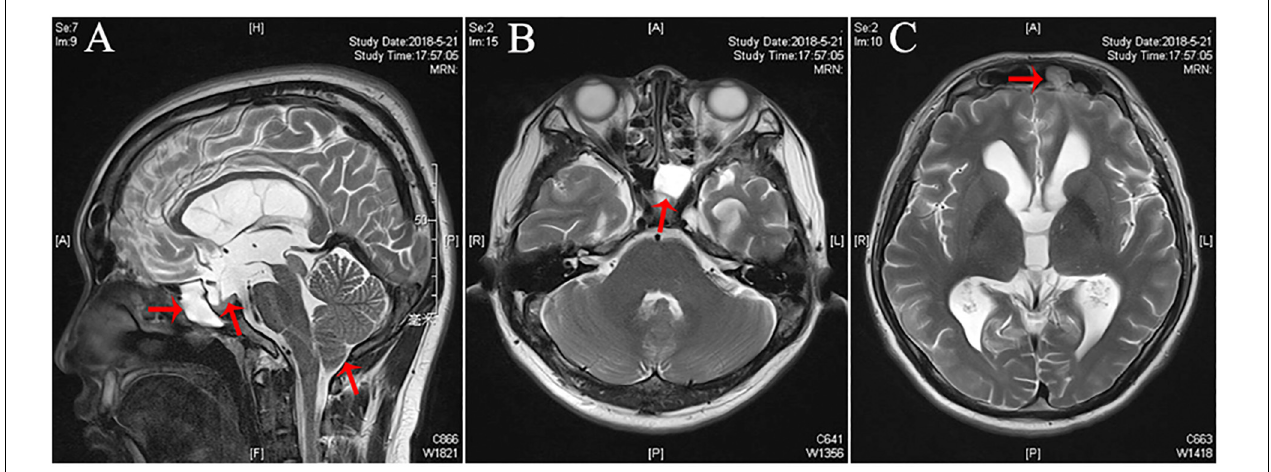
FIGURE 1 | Pre-operative imaging of the patient with CSF rhinorrhea. (A) Pre-operative sagittal T2-weighted magnetic resonance imaging (MRI) demonstrating hyperintense in the left sphenoidal sinus, partial empty sella, and Chiari I malformation (CIM) (arrows). (B) Pre-operative axial T2-weighted MRI demonstrating hyperintense in the left sphenoidal sinus (arrows). (C) Pre-operative axial T2-weighted MRI demonstrating a left sided meningoencephalocele (arrow) extending into the left frontal sinus.